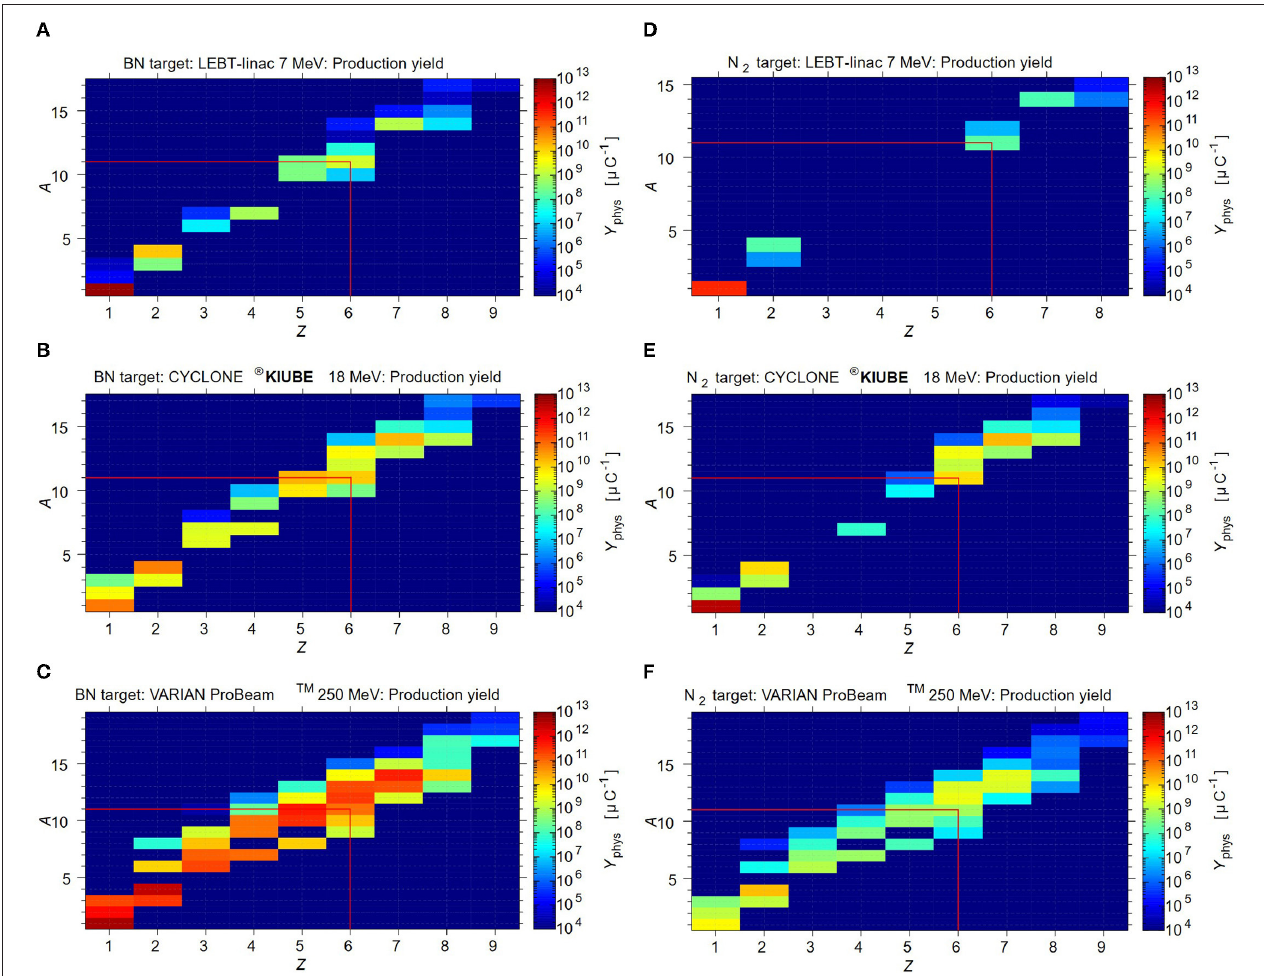
FIGURE 5 | FLUKA simulations for the physical production yield for the different target+beam options. The yield is expressed in nuclei per µ C. (A) BN target + 7 MeV beam, (B) BN target + 18 MeV beam, (C) BN target + 250 MeV beam (D) N 2 target + 7MeV beam, (E) N 2 target + 18 MeV beam, (F) N 2 target + 250 MeV